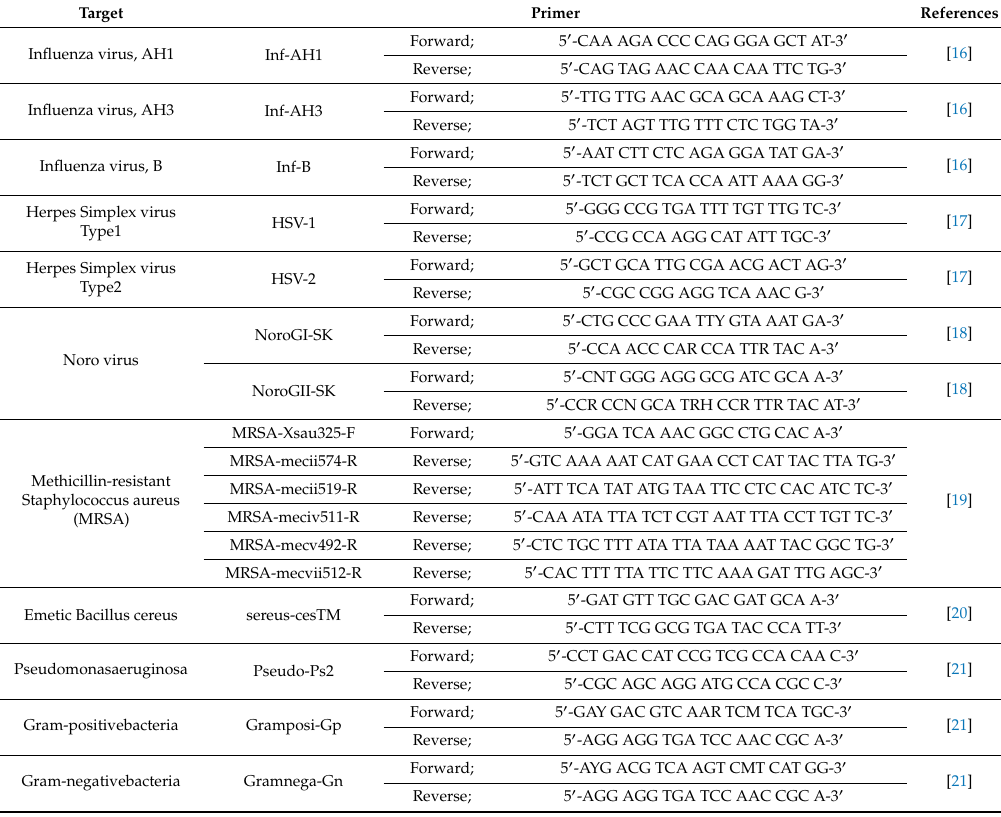
Table 1. Primers for